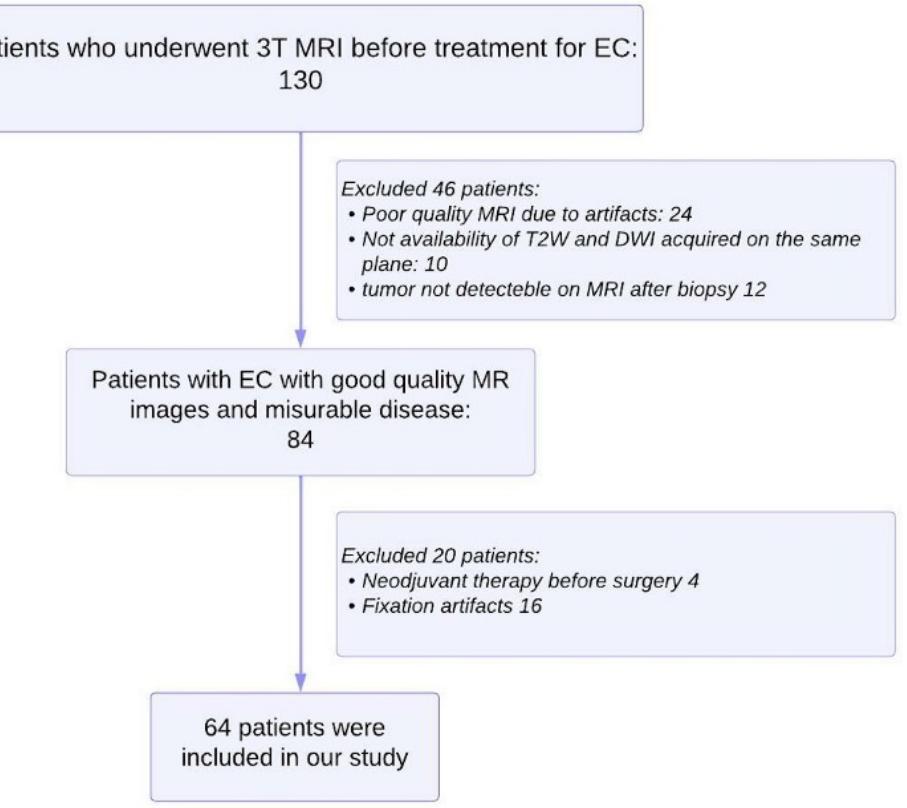
Figure 1. Flowchart shows selection of study population and exclusion criteria.